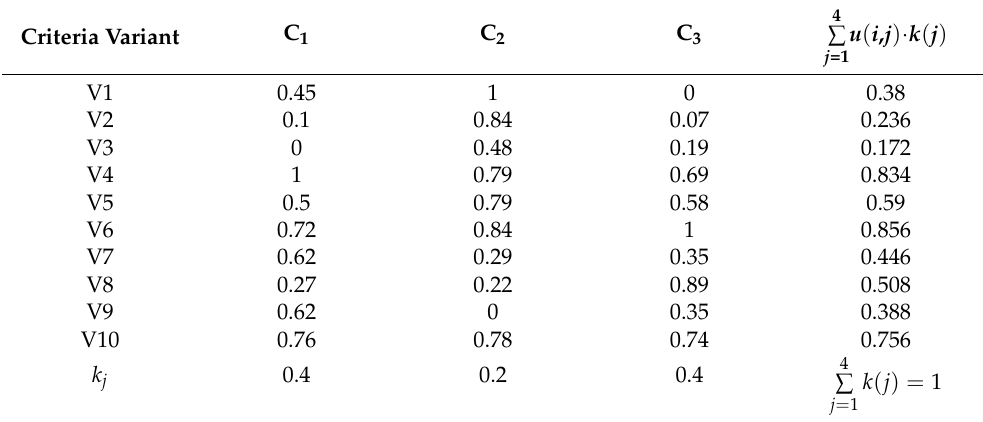
Table 6. Utility and decision matrix for training cells